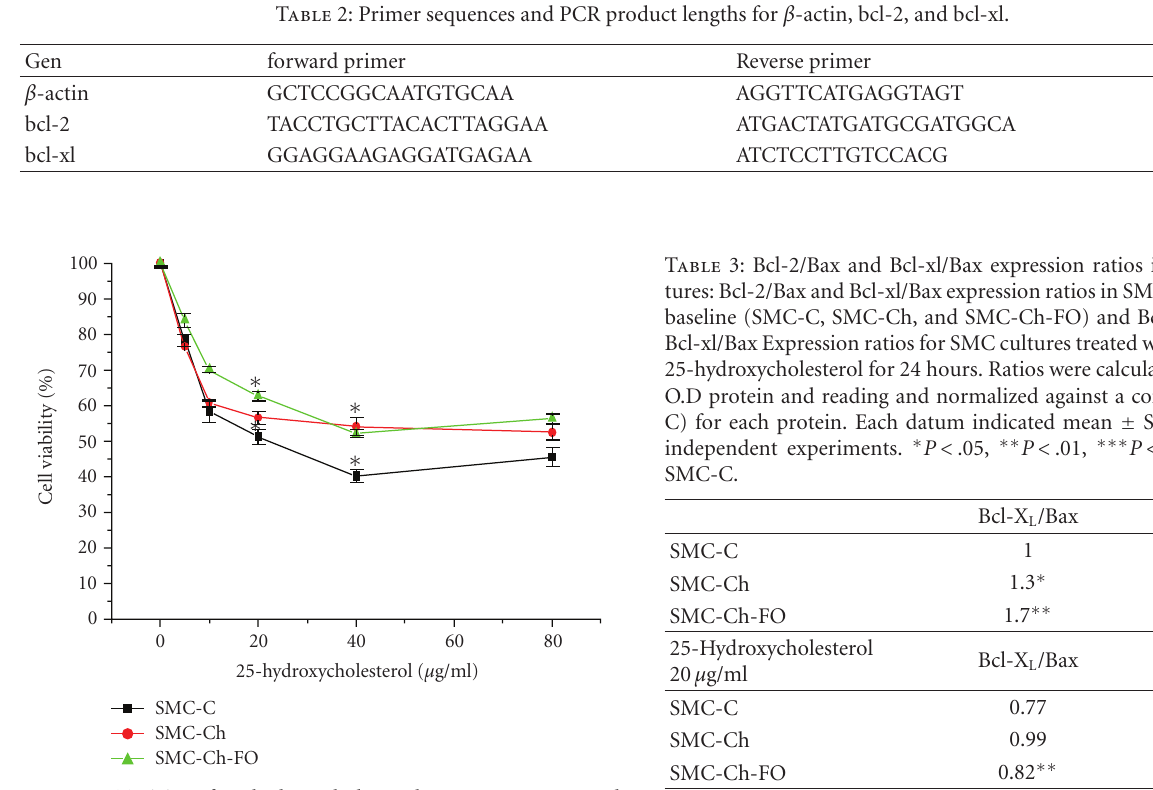
Table 2: Primer sequences and PCR product lengths for β -actin, bcl-2, and bcl-xl.